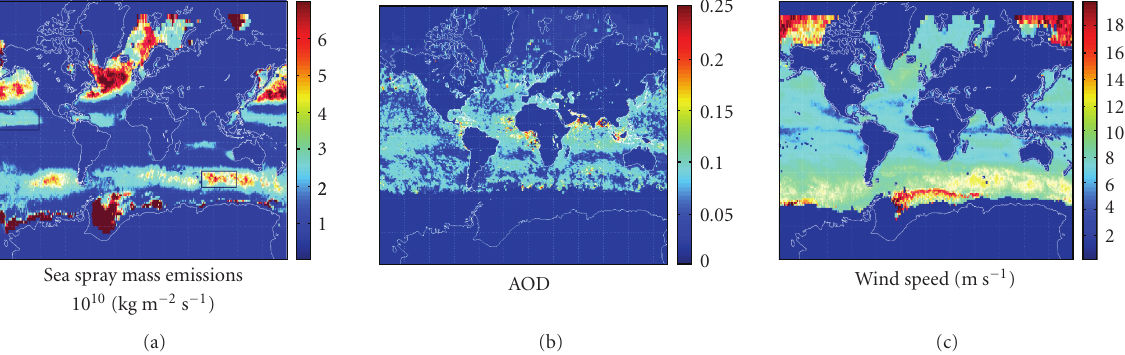
Figure 1: (a) depicts a global sea spray mass emissions map scheme illustrating areas for which AOD was examined in the North Pacific and Southern oceans, (b) illustrates global annual average AOD for June 2006, and (c) shows the average monthly wind